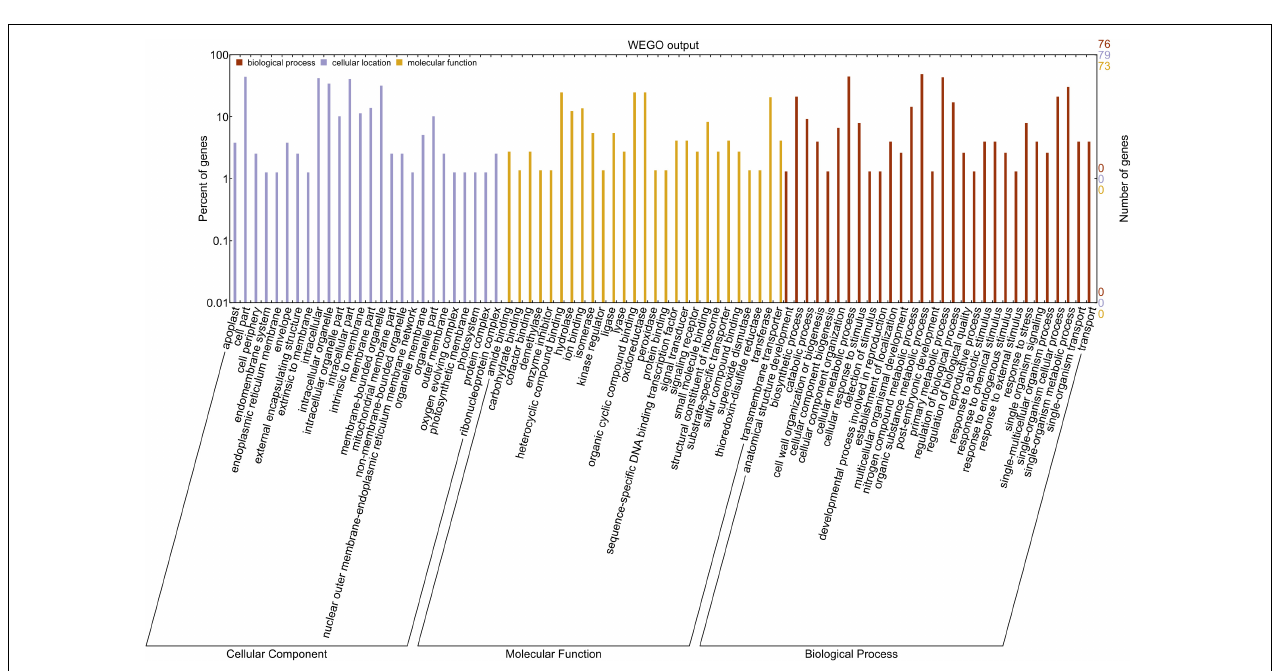
FIGURE 5 | Evaluation of number of subgroups based on “STRUCTURE” output. (A) Delta K , best value of K = 3. (B) Bar plot showing distribution of 20 wheat genotypes into 3 subgroups as shown in green, blue, and red colors.